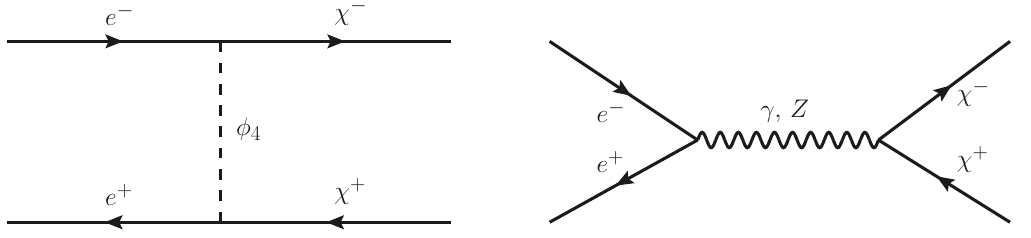
Figure 10 . Charged particle production at the e + e − collider with dark matter φ 4 as one of the intermediate